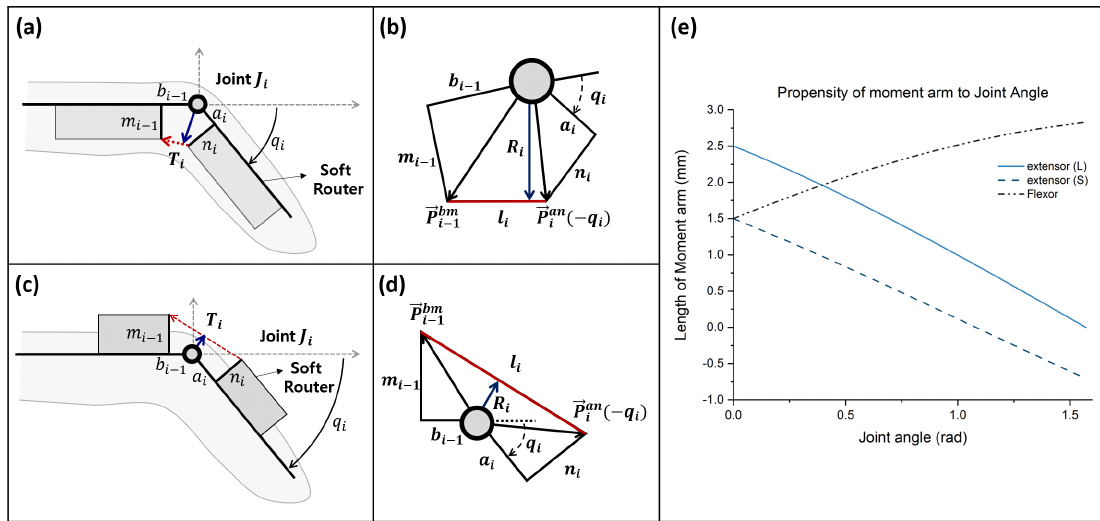
Figure 2. Schematic view of the tendon routing method in the Exo-Index; ( a ) and ( b ) show a schematic of the flexor router, while ( c ) and ( d ) show a schematic of the extensor router; ( e ) shows aspects of how the moment arm changes with respect to variation of the joint angle. Here, length of the flexor router and extensor (S) router ( a i , b i − 1 , m i − 1 , and n i ) each are 5, 5, 3, and 3 mm, while m i − 1 , and n i of the extensor (L) router is increased to 5